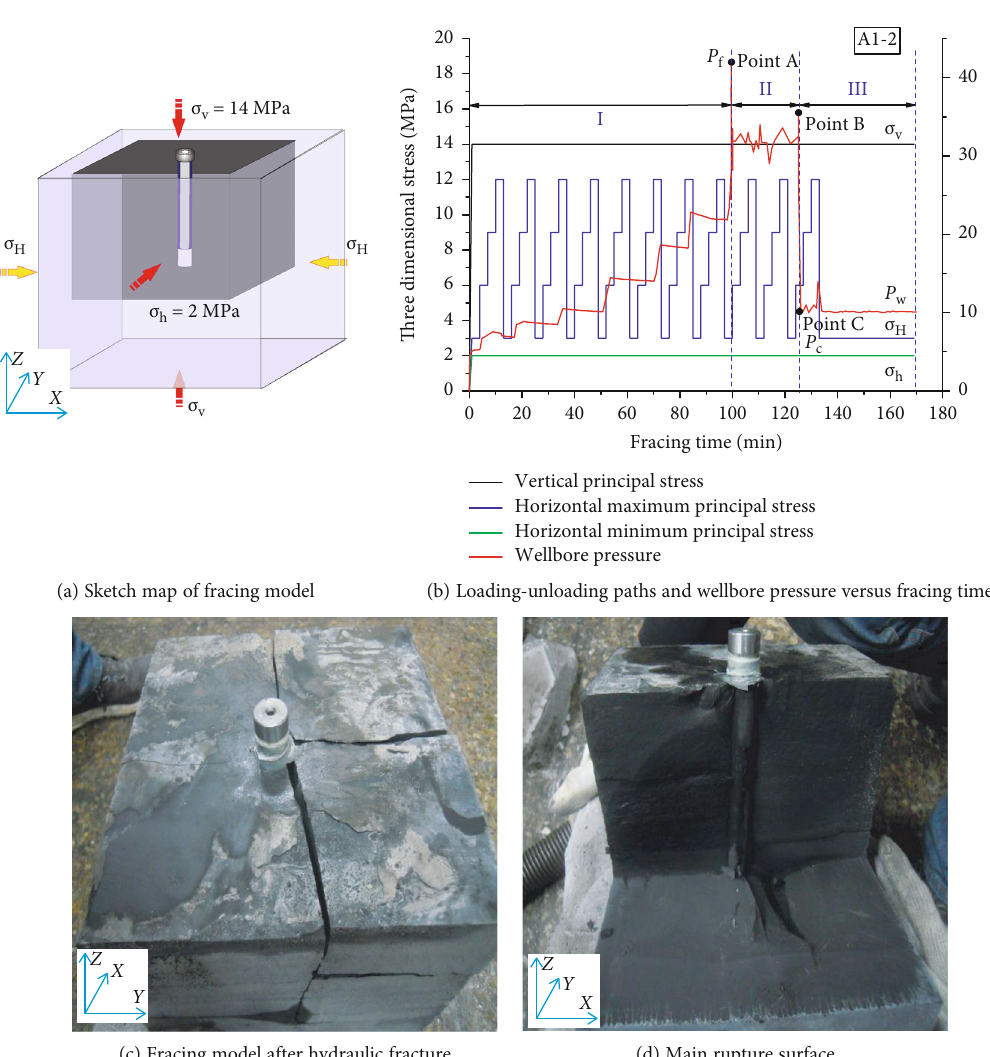
Figure 12: Loading-unloading paths and failure patterns for specimen